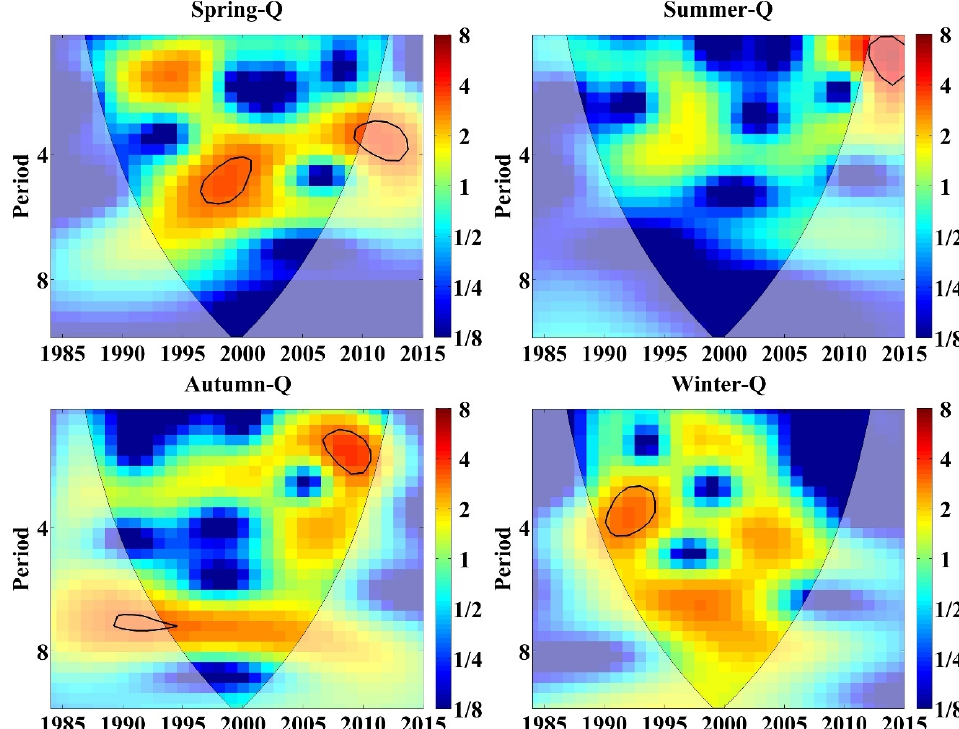
Figure 10. The continuous wavelet power spectra of seasonal runoff in the Yinjiang River watershed. The thick black contour designates the 5% significance level against red noise and the cone of influence (COI) where edge effects might distort the picture is shown as a lighter shade.